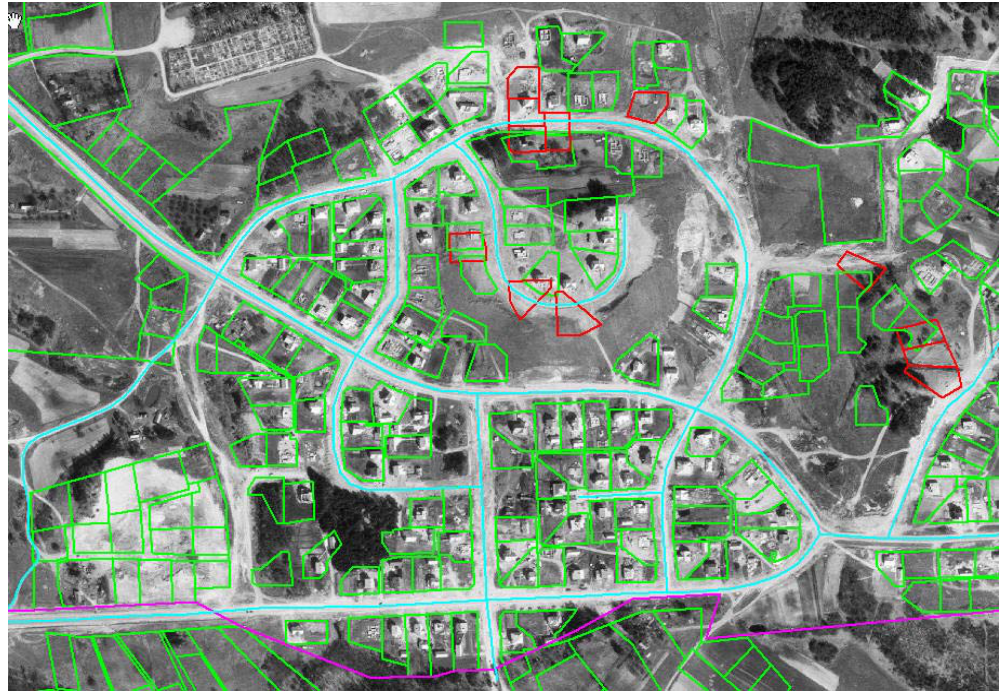
Fig 1. Excerpt from a cadastral